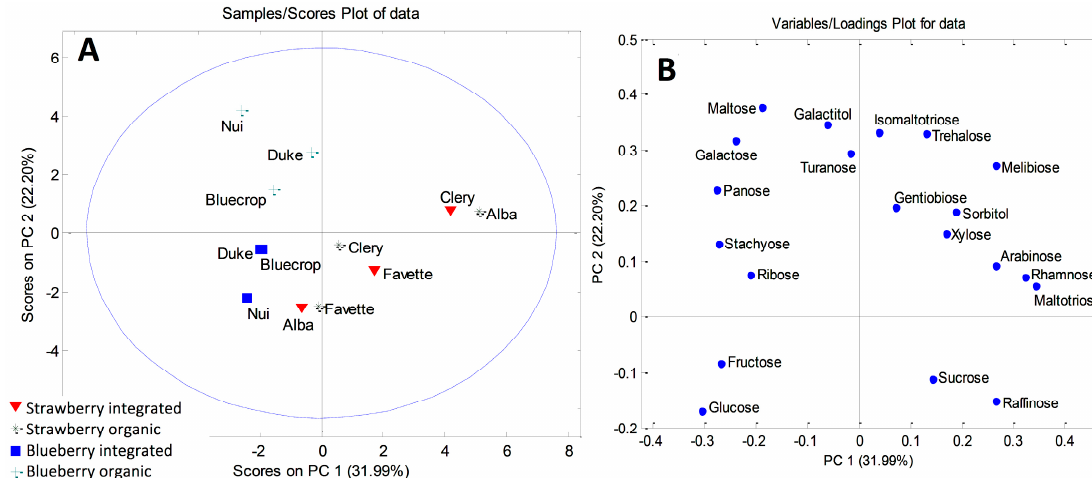
Figure 2. PCA model for sugar-based classification and di ff erentiation of blueberry and strawberry leaves: ( A ) score plot; ( B ) loading